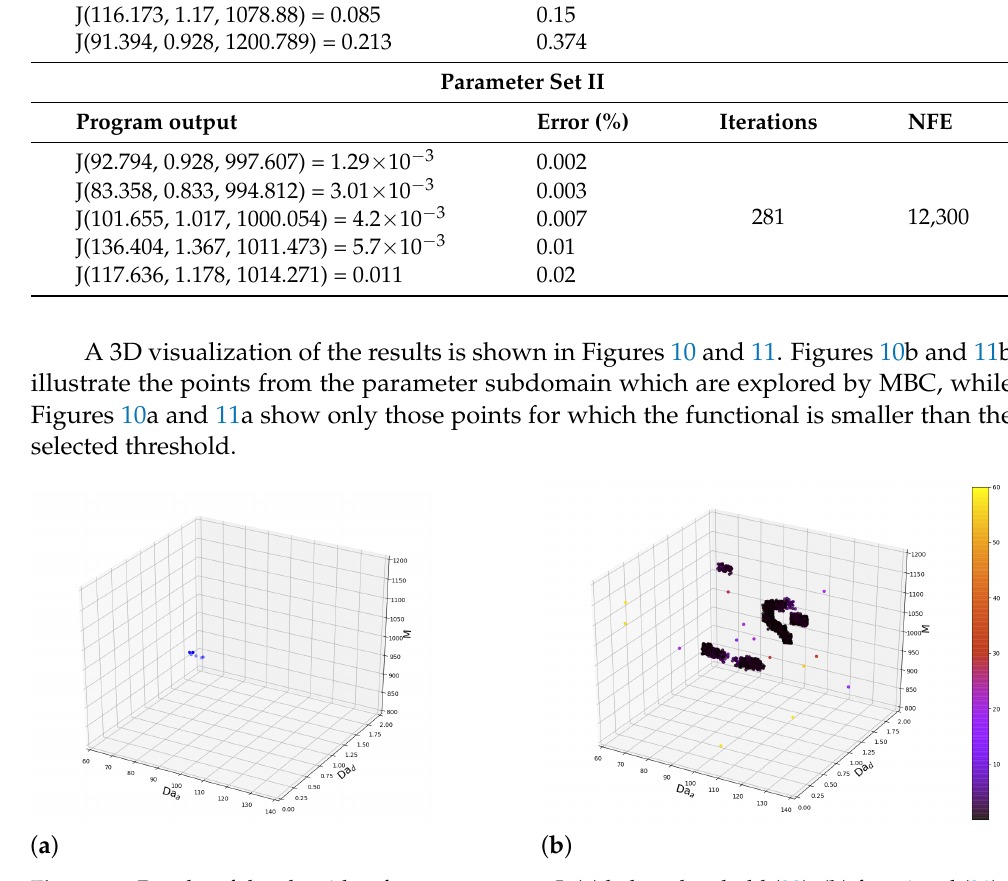
Figure 10. Results of the algorithm for parameter set I: ( a ) below threshold (22), ( b ) functional